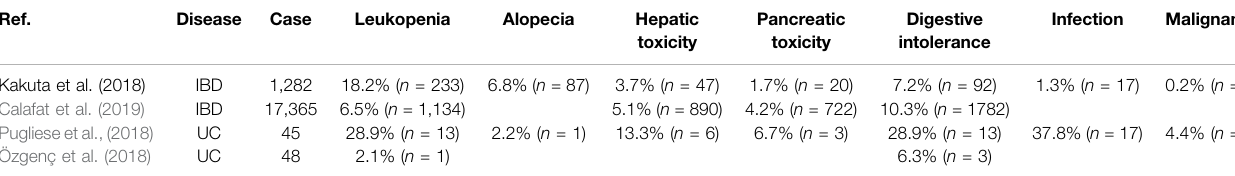
TABLE 1 | Adverse event rates for thiopurines in patients with IBD.